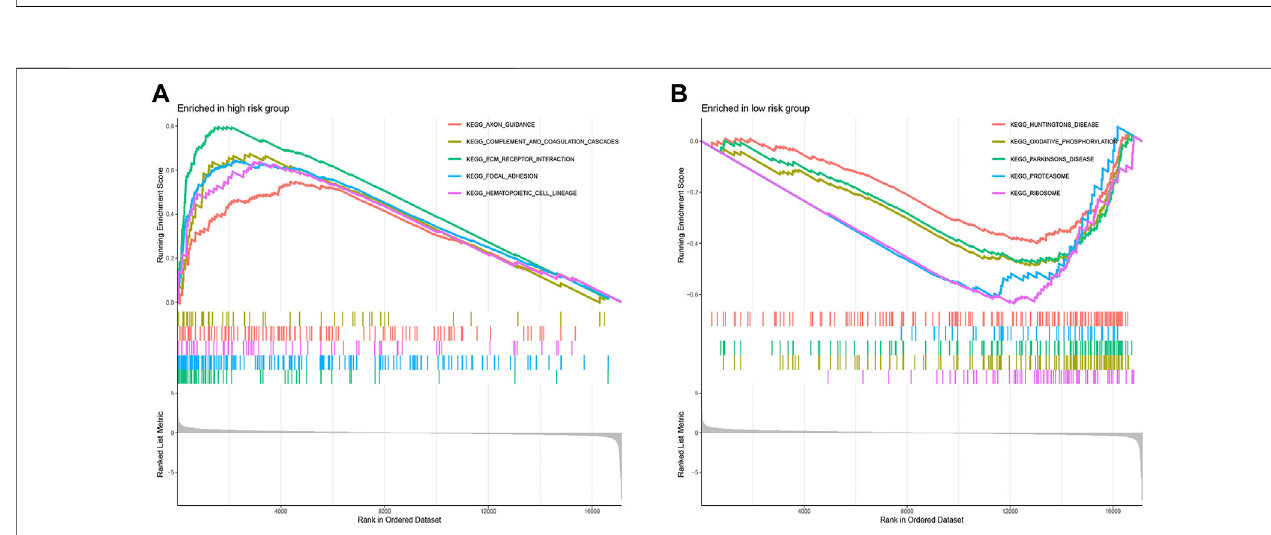
Frontiers in Genetics |